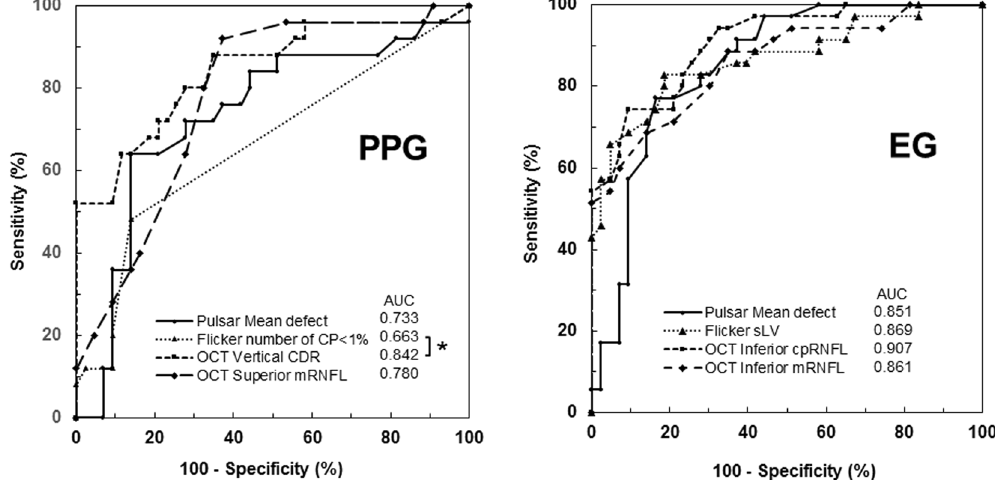
Figure 1. Receiver operating characteristic curve of each device. Area under the curve (AUC) of the best parameters from Pulsar perimetry, Flicker perimetry, optical coherence tomography (OCT) disc measurement, and OCT macular measurement in pre-perimetric glaucoma (PPG) and early glaucoma (EG). The ( * ) shows significance at p = 0.016 by the DeLong